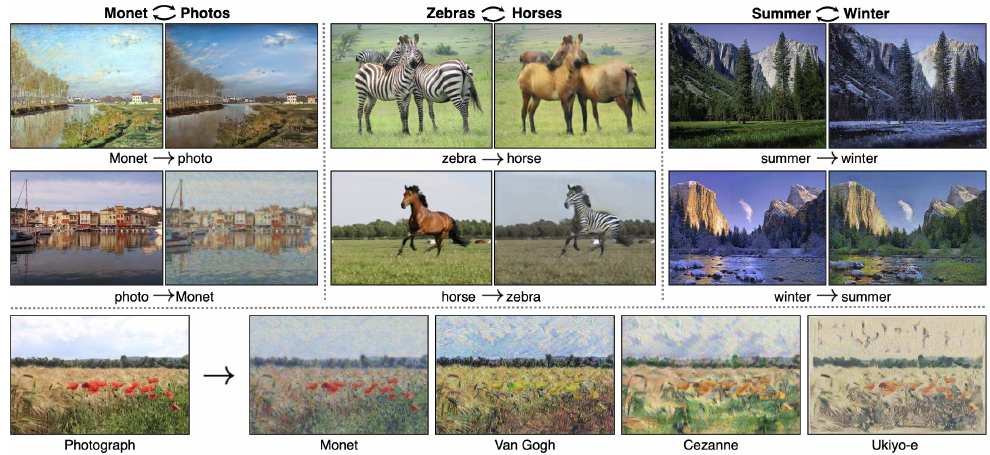
Figure 13. Given any two image collections, the CycleGAN learns to automatically “translate” an image from one domain into the other and vice versa. Example application (bottom): using a collection of paintings of famous artists, the CycleGAN renders a user’s photograph in their style. Image taken from